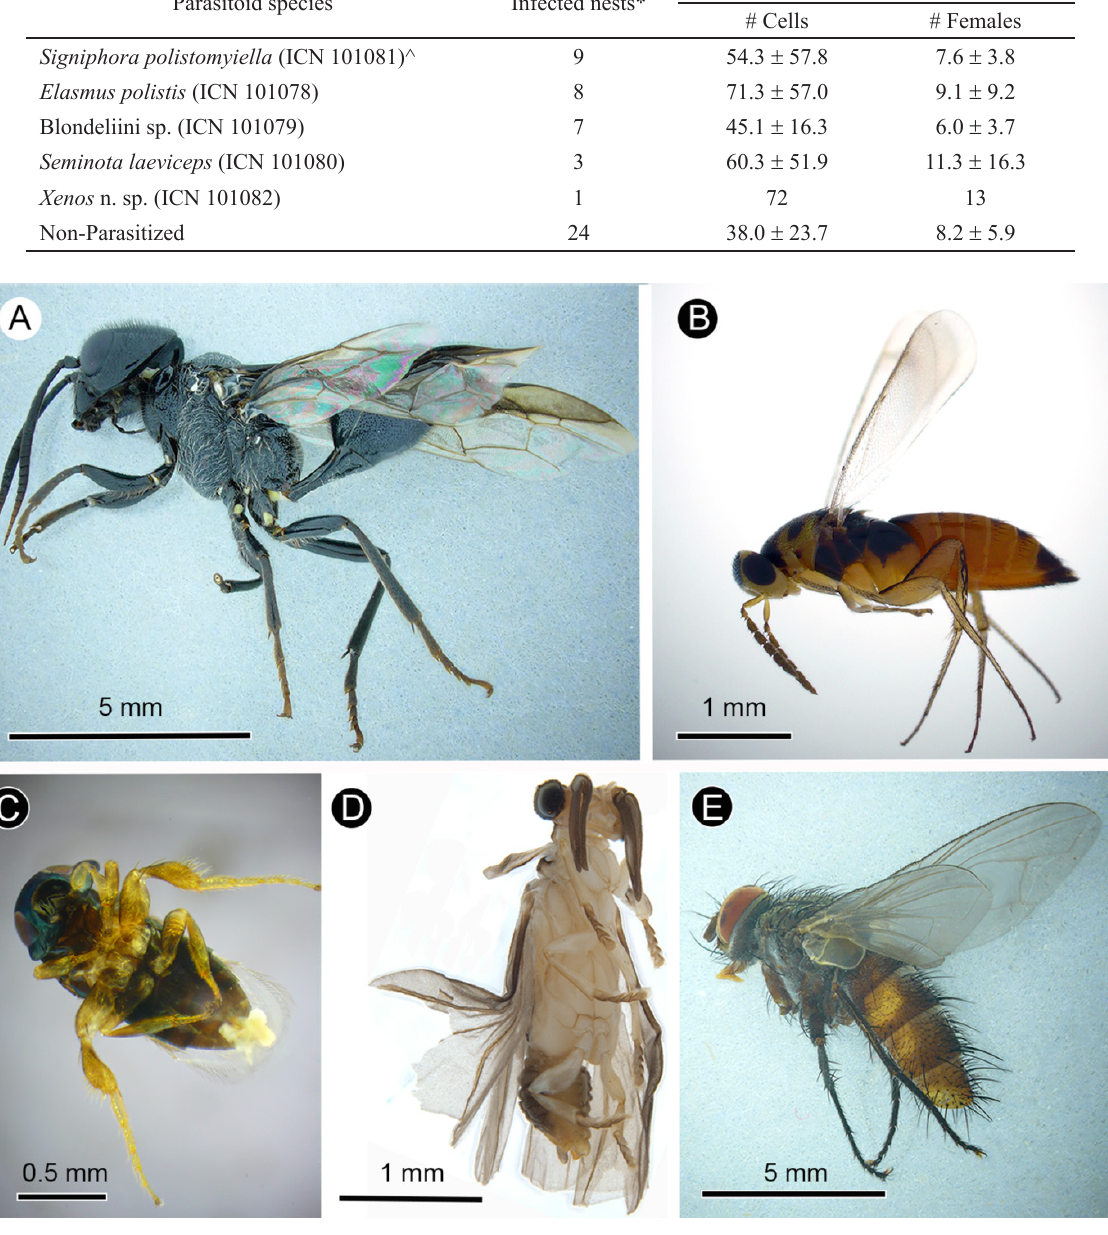
Fig 1 . Habitus of the parasioids reported in the colonies of Polistes myersi and Polistes erythrocephalus . (A) Seminota laeviceps , (B) Elasmus polistis , (C) Signiphora polistomyella , (D) Xenos n. sp, and (E)